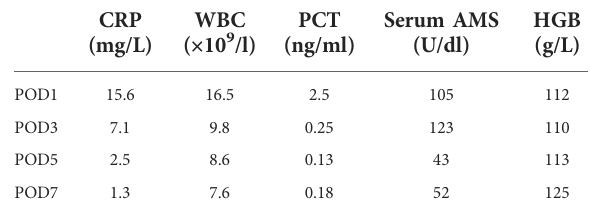
TABLE 1 The amylase and volume of abdominal drainage tubes.